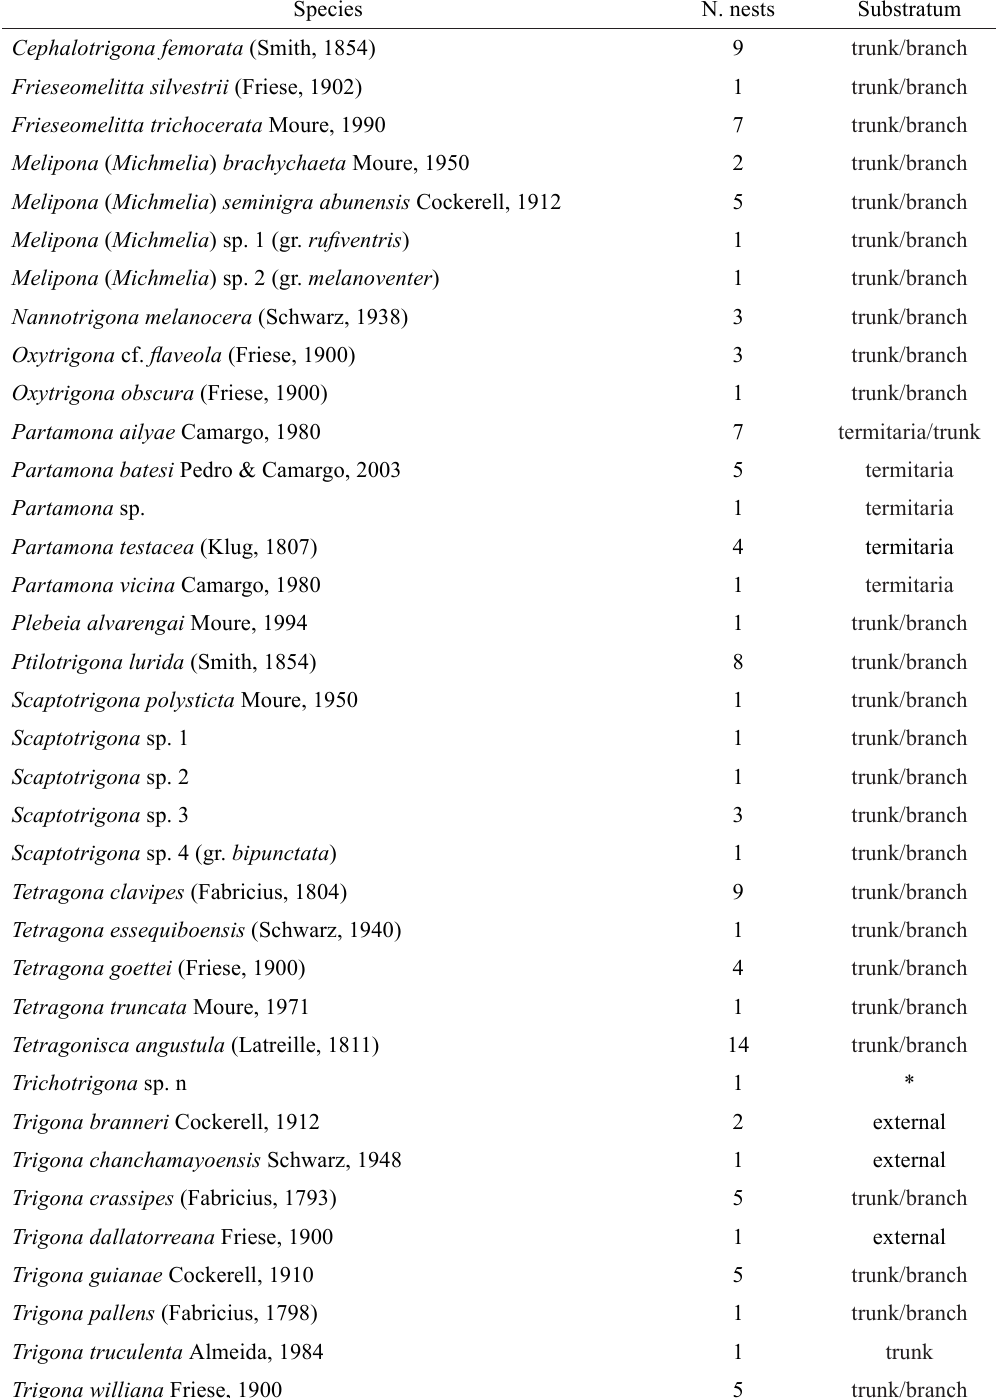
Table 2. Species identified during the Meliponini rescue at Santo Antônio Dam, Madeira River, Brazil. Species N.